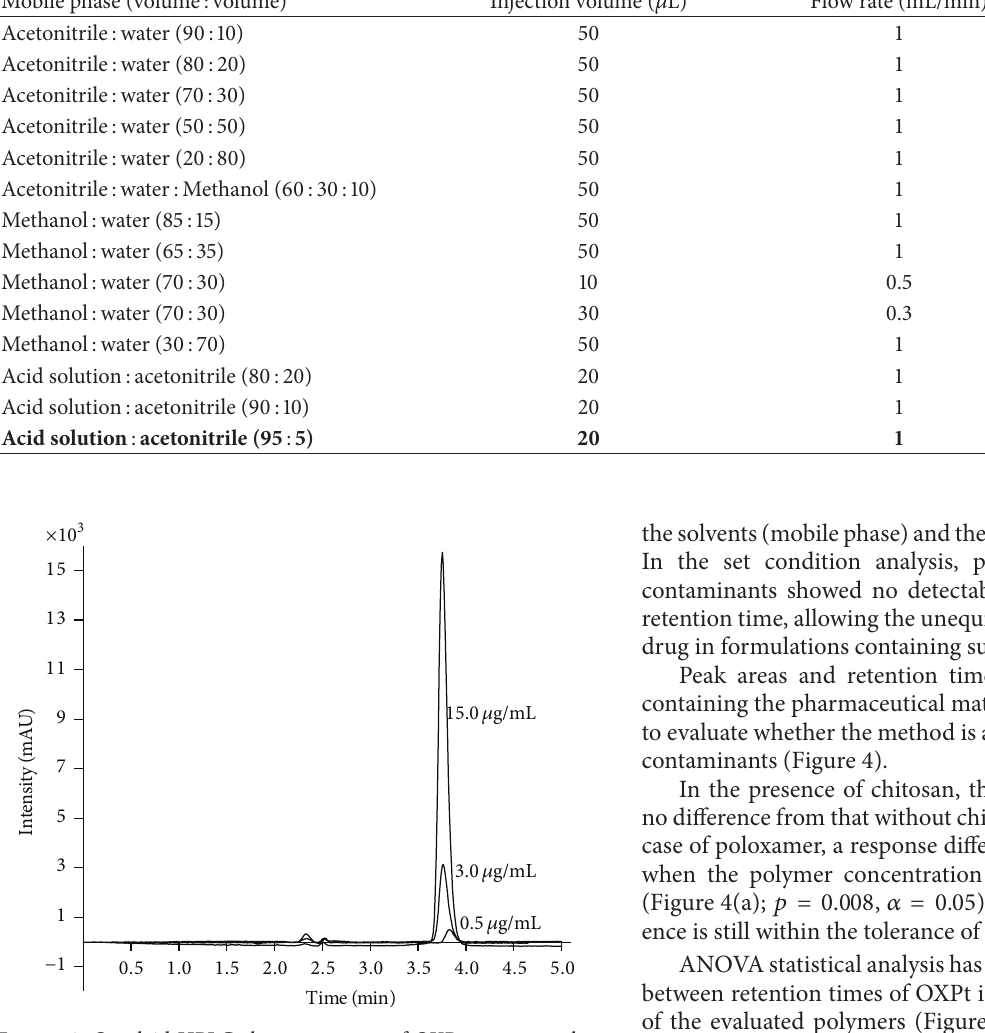
Figure 2: Overlaid HPLC chromatograms of OXPt aqueous solu- tions analyzed at different concentrations (0.5, 3.0, and 15.0 𝜇